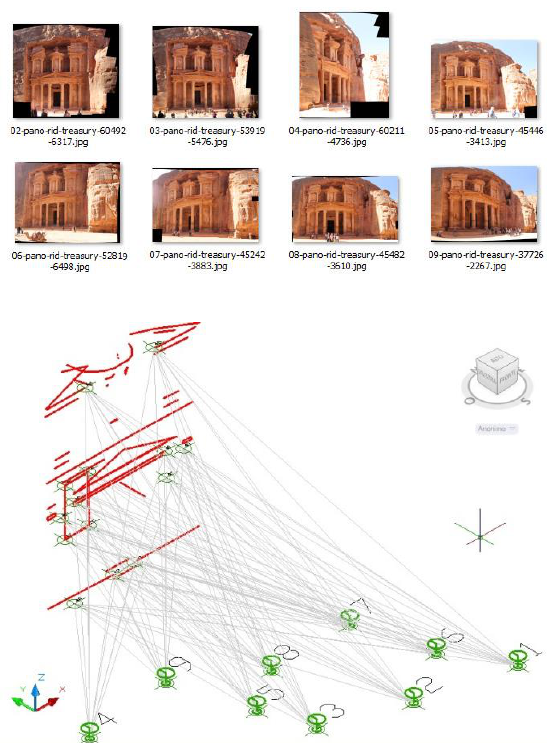
Figure 2. Facade, El Khasneh al Faroun ("The Treasury“), Jordan. 8 input panoramas (resolution of 10000x10000 px approx.) and restitution lines by